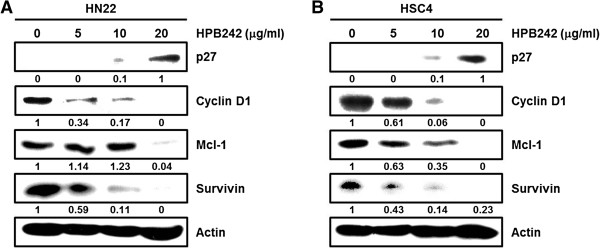
The effect of HPB242 on downstream target proteins by the specificity protein 1 (Sp1). HN22 (A) and HSC4 (B) cells were incubated with HPB242 (0, 5, 10 and 20 μg/ml) for 48 h. The effect of HPB242 for 48 hours on p27, Cyclin D1, Mcl-1, and Survivin was determined by Western blots. Fifty micrograms of cellular extract per lane was separated on an SDS-PAGE gel as described in Methods. Equal loading of protein was confirmed by incubating the same membrane with anti-β-Actin antibody.